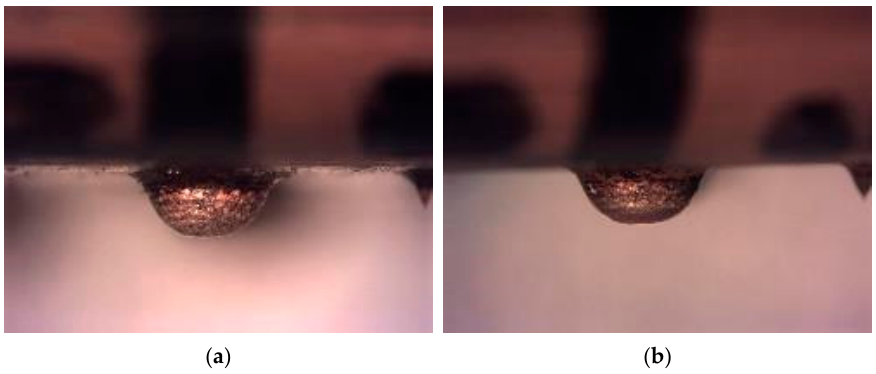
Figure 16. Semi sphere 1.1. ( a ) Before erosion process ( b ) After first erosion process.